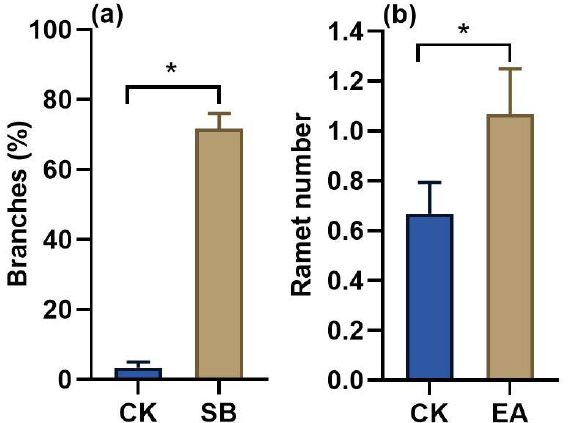
Figure 4. ( a ) Percentage of branches forming adventitious roots after Caragana stenophylla branches were sand buried (mean ± SE). CK, control; SB, sand burial. ( b ) Ramet establishment on the horizontal buried roots and the exposed roots for Caragana stenophylla (mean ± SE). CK, buried roots; EA, exposed roots. * indicate significant differences between treatments, p < 0.05, t -test.